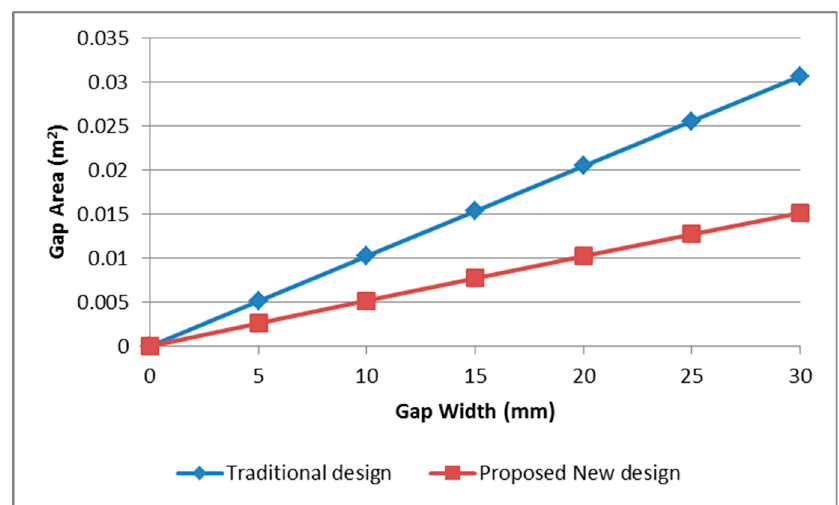
Figure 4. Gap area dependence on gap width in the traditional and the proposed new door design.